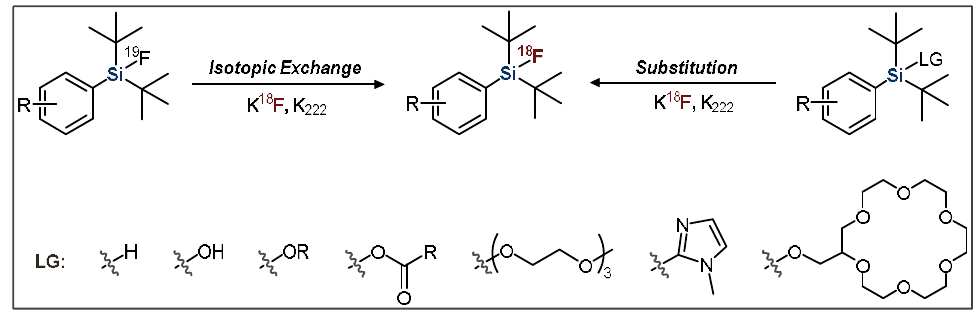
Figure 1. General scheme for the radiofluorination of SiFA compounds. LG = leaving group.